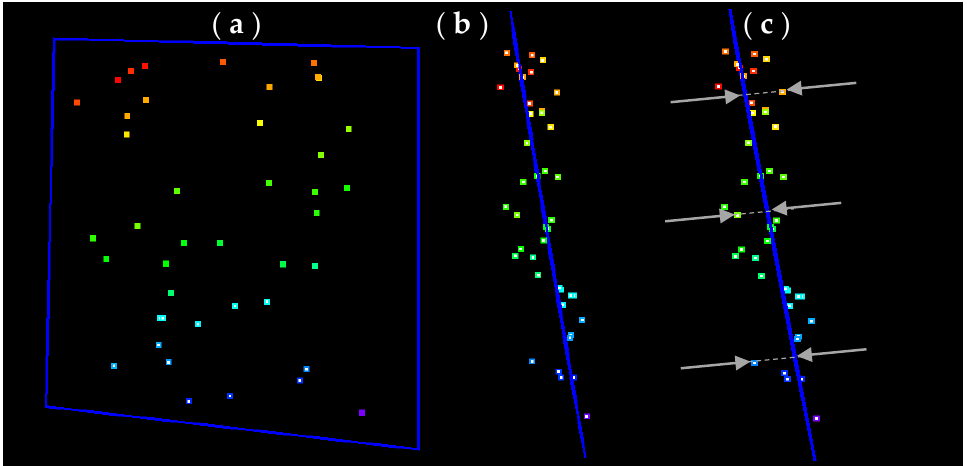
Figure 4. Smooth surface precision. ( a ) Selected points for a plane modeling. ( b ) Side view projected along the regression plane. ( c ) Normal distances from points to the plane with three example points.